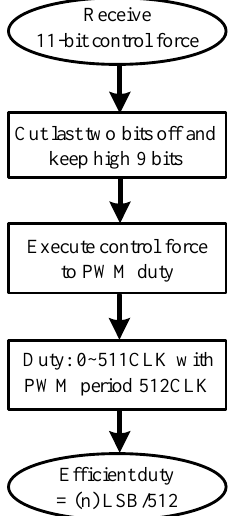
Figure 10. Program flow chart for the traditional PWM strategy.